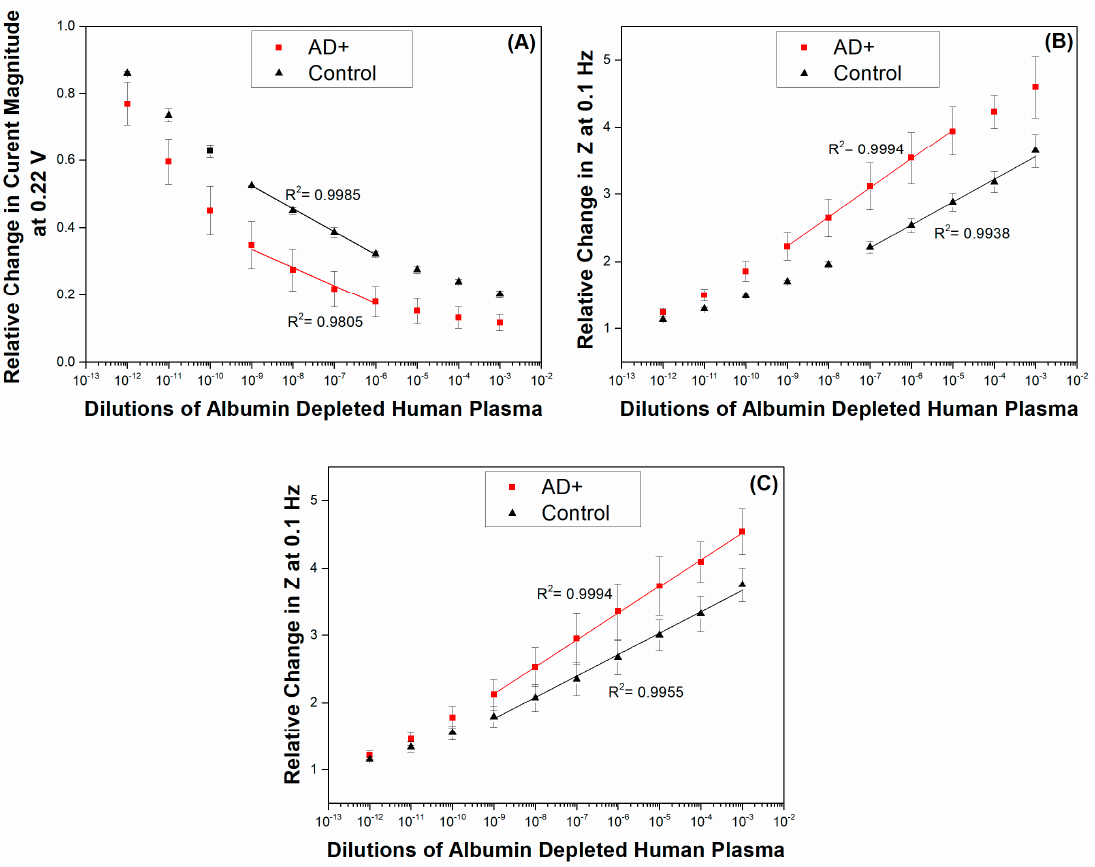
Figure 5. Logarithmic plots derived from ( A ) CV data showing the relative changes in current magnitudes at a bias potential of 0.22 V and ( B ) EIS data showing the relative changes in total impedance (Z) at 0.1 Hz, for AD (1) and control (2) cases against the baseline response (plain PBS) versus the range (10 − 12 to 10 − 3 ) of 10-fold dilutions of albumin depleted human plasma; ( C ) cumulative set for relative changes in total impedance (Z) at 0.1 Hz from AD cases (1 and 3) and control cases (2 and 4). Tested in 10 mM PBS containing 5 mM [Fe (CN) 6 ] 4 − /3 − and 150 mM NaCl. Electrode surface area: 0.02 cm 2 . Error bars are sample standard deviations of measurements on n = 2 samples for ( A , B ) and 3 samples for ( C ). Z is given by the following equation (cid:1852) (cid:3047)(cid:3042)(cid:3047) = (cid:3495)(cid:1852) (cid:3045)(cid:3032)(cid:3028)(cid:3039)(cid:2870) + (cid:1852) (cid:3036)(cid:3040)(cid:3028)(cid:3034)(cid:2870) .